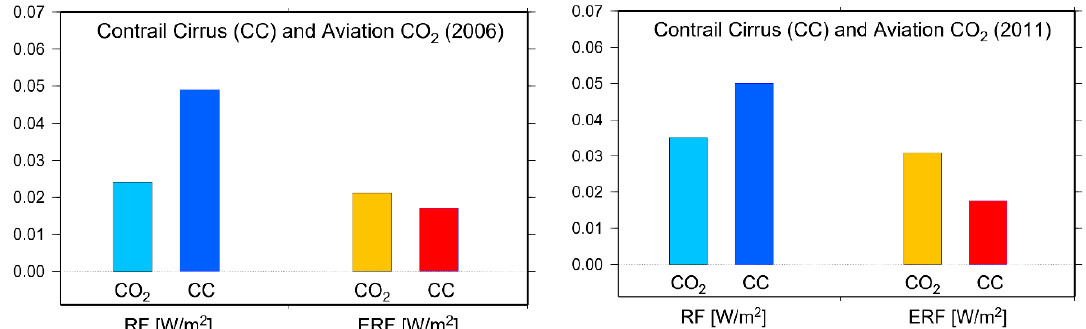
Figure 5. Classical RF from contrail cirrus and CO 2 (dark and light blue, respectively) for realistic aviation scenarios: values adopted from [4] ( right box) as well as from [26] ( left box). The ERF (red) counterparts have been yielded using the ERF/RF reduction factors as derived by [16]. Uncertainty bars have been deliberately omitted (but are discussed in the text).